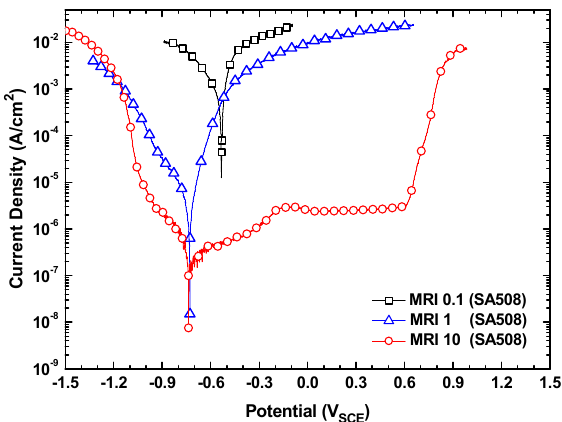
Figure 3. Polarization curves of SA508 in the solutions of the MRI 0.1, 1 and 10 at a total sodium and